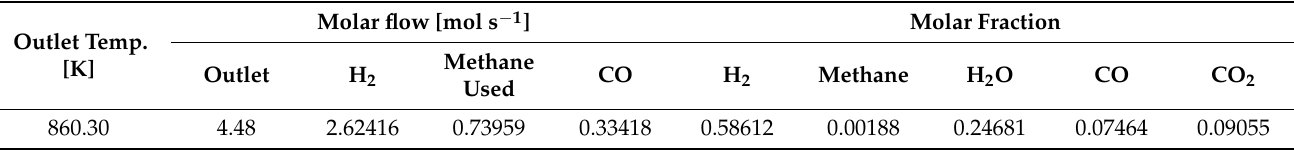
Table 1. Results for the reformer outlet side.